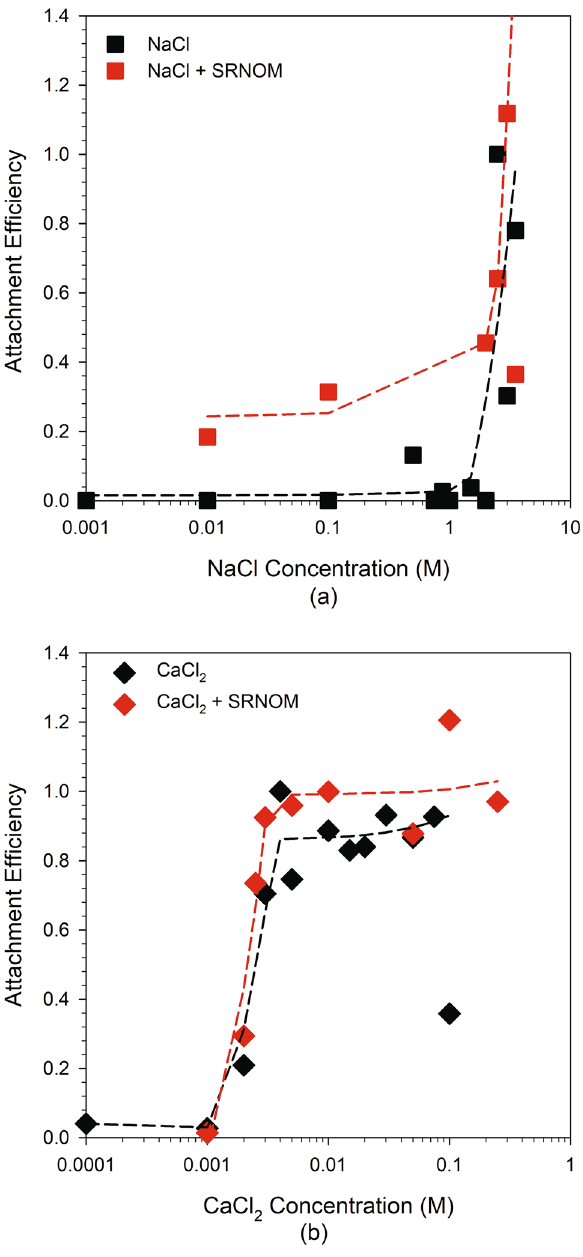
Fig. 10 Attachment efficiency of QDs suspended in aqueous chlo- ride salt solutions as a function of the types and concentrations of electrolytes and the absence and presence of SRNOM at 10 mg/L: a Monovalent electrolyte NaCl in both the absence and presence of SRNOM at 10 mg/L, b Divalent electrolyte CaCl absence and presence of the SRNOM at 10